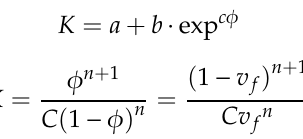
Figure 6. Permeability testing of woven jute fabric with glycerin solution at ament conditions. Adapted from [24], with permission from © 2010, Elsevier. ( a ) Plot of square of flow front position with times for different infusion conditions (related to Darcy’s law). ( b ) Plot of saturated and unsaturated permeability against porosity (= 1 – fibre volume fraction) (related to the Carman – Kozeny equation).